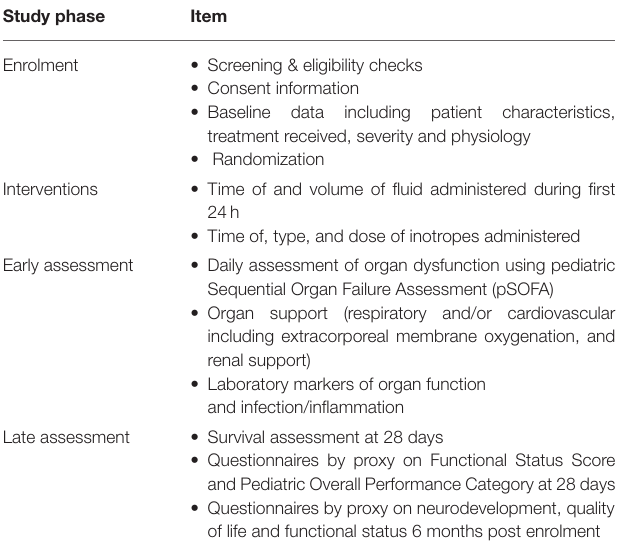
TABLE 3 | Study schedules to be captured in the study